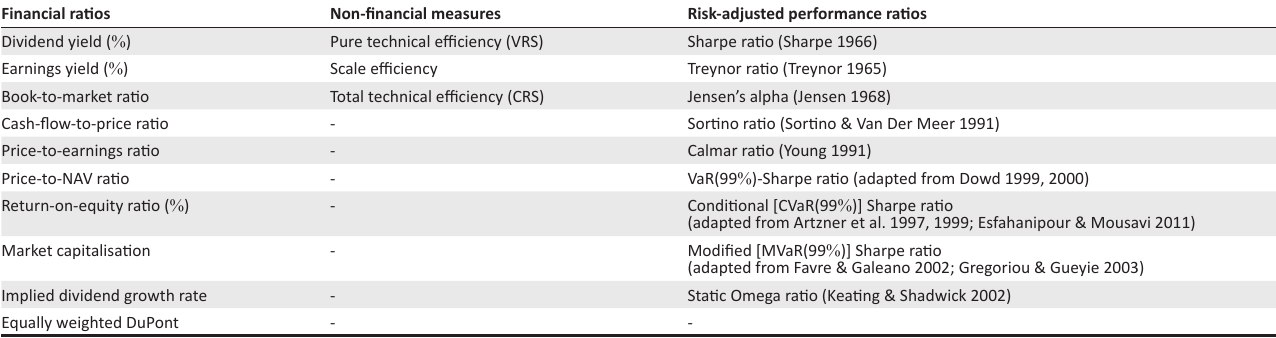
TABLE 3: The financial, non-financial and risk-adjusted performance ratios and measures under evaluation. Financial